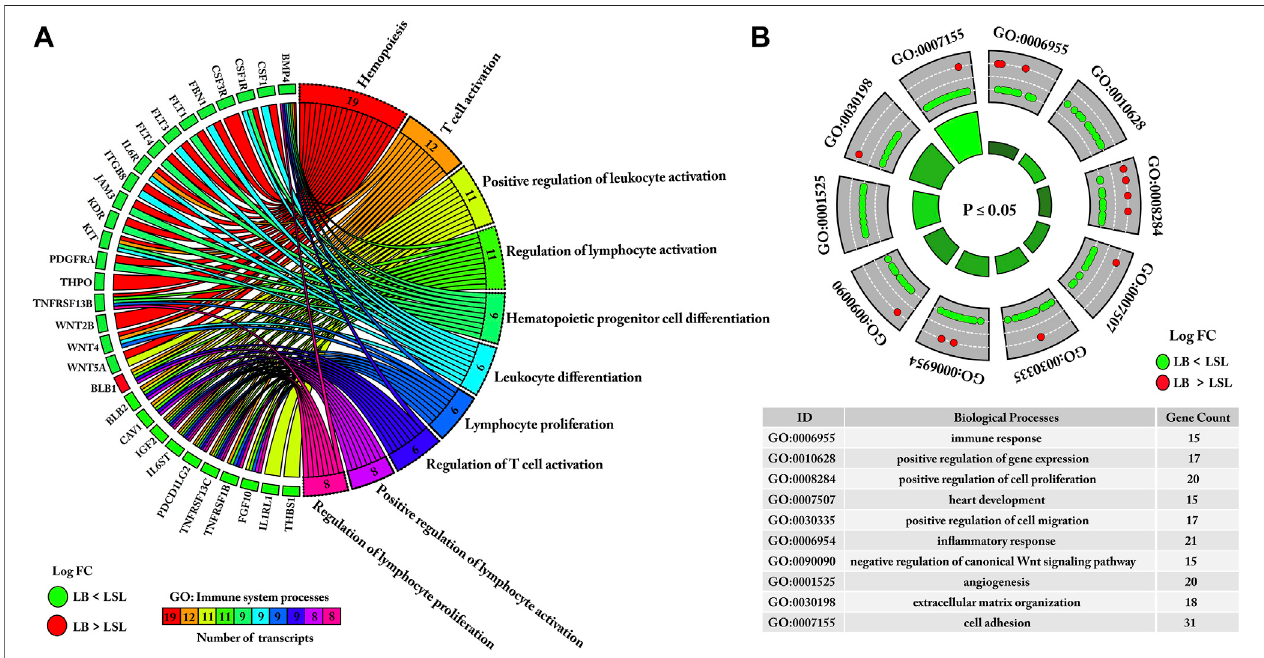
FIGURE 7 | Gene ontology enrichment analysis of DE mRNAs negatively correlated with bio-signature miRNAs. (A) miRNAs and their negatively correlated DE targetgenesweresubjectedtoenrichmentanalysisofgeneontology(GO)(immunesystemprocesses).TheinnerpartoftheCircosplotrepresentslinksofDEgenesand identi fi edGOterms. (B) GeneOntology(biologicalprocesses)enrichmentanalysiswasperformedonbio-signaturemiRNAsandtheirnegativelycorrelatedtargetgenes. Theinner whitedotted linerepresentsthepartitionoflogFCfrom lowertohigher levels. ThegreenisdownregulatedinLBandthered isupregulatedinLB. Immune system processes and biological processes with p ≤ 0.05 were considered signi fi